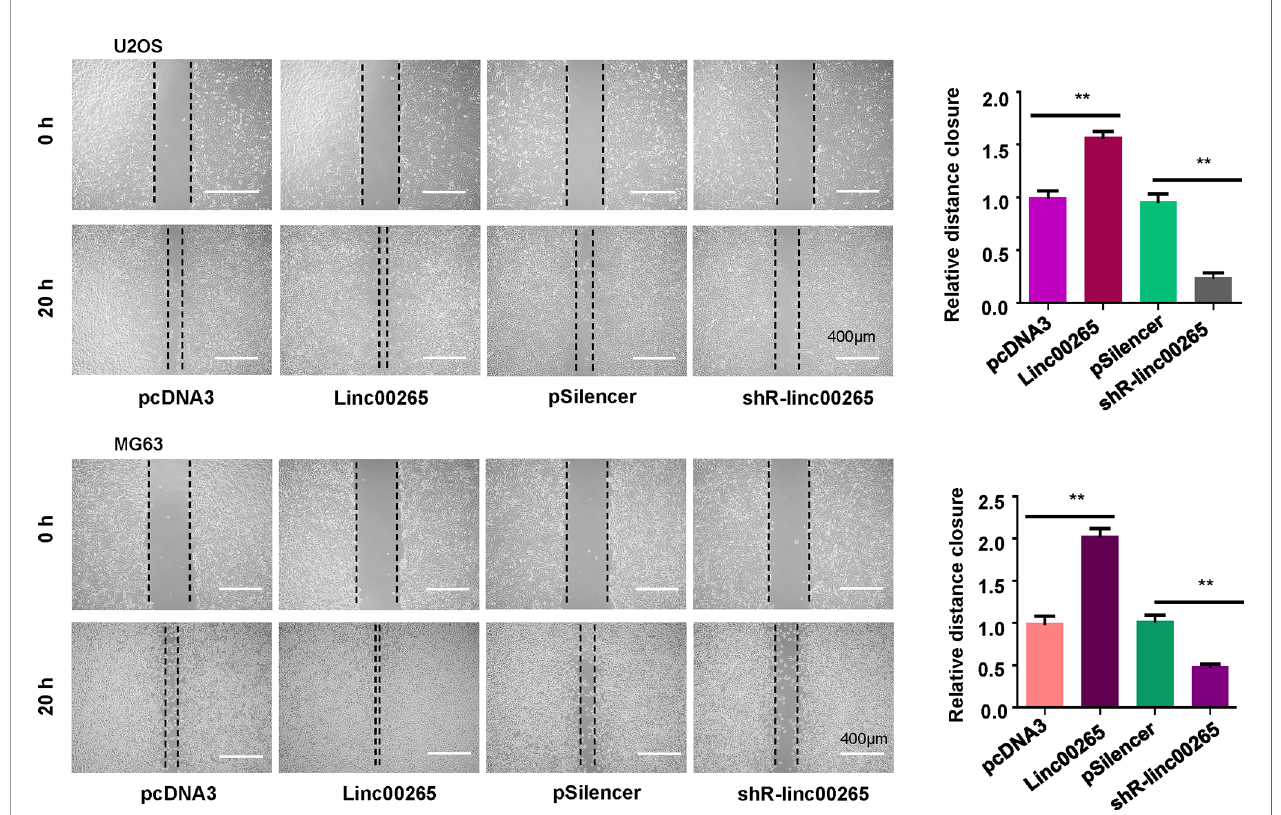
FIGURE 3 | Linc00265 overexpression promotes migration of osteosarcoma cells. Wound healing assay was utilized to examine the cell migratory ability in U2OS and MG63 osteosarcoma cells after linc00265 modi fi cation (Left panel). The quantitative data of wound healing assays were demonstrated (Right panel). ** P < 0.01 vs.